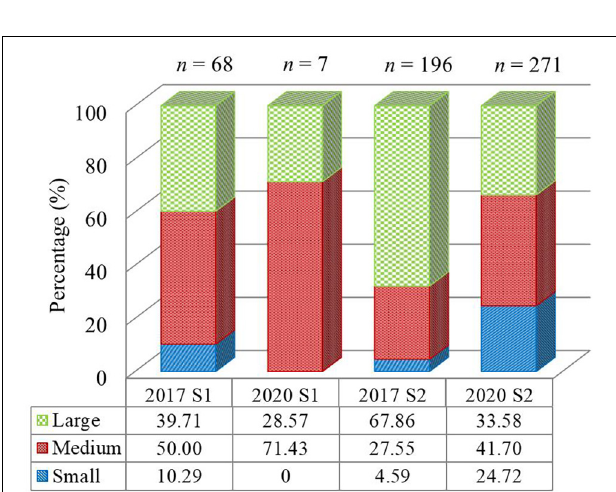
FIGURE 7 | Population structure of the Holothuria leucospilota in summer 2017 and 2020. Size classified by wet weight: small ( ≤ 90 g), medium (90–180 g), and large ( ≥ 180 g). n =